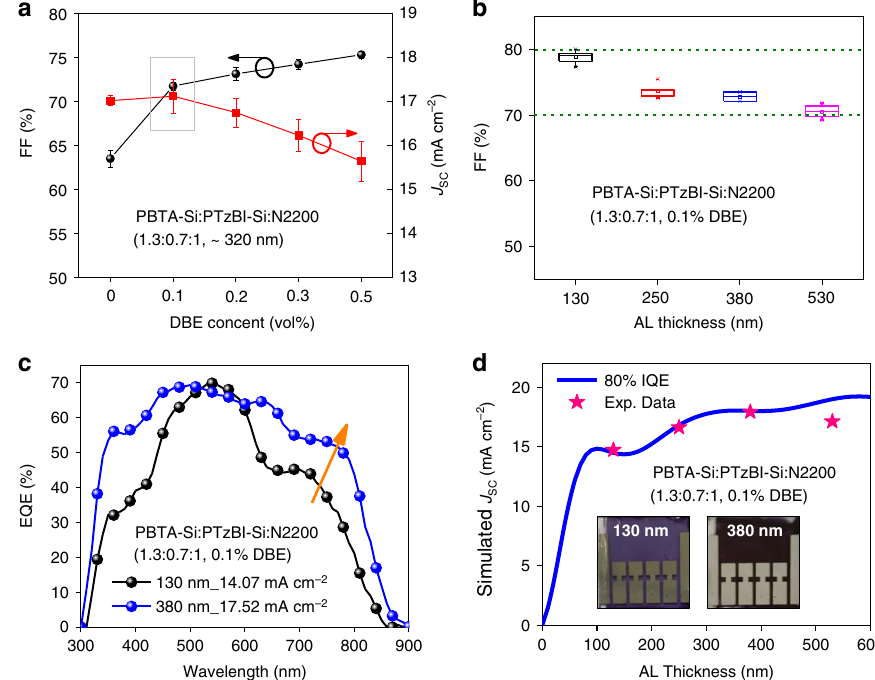
Fig. 2 Photovoltaic performance for thick cells based on PBTA-Si:PTzBI-Si:N2200. a Dependence of FF and J SC on DBE content for 1.3:0.7:1 cells in thick- fi lm condition. b FF versus active layer (AL) thickness for 1.3:0.7:1 cells containing 0.1 vol% DBE. c EQE response for 1.3:0.7:1-cells with 0.1% DBE; the arrow indicates the EQE increase in NIR region. d Simulated J SC at 80% IQE and the experimental J SC values; insets are photos of 130-nm and 380-nm cell on a 1.5 × 1.5 cm 2